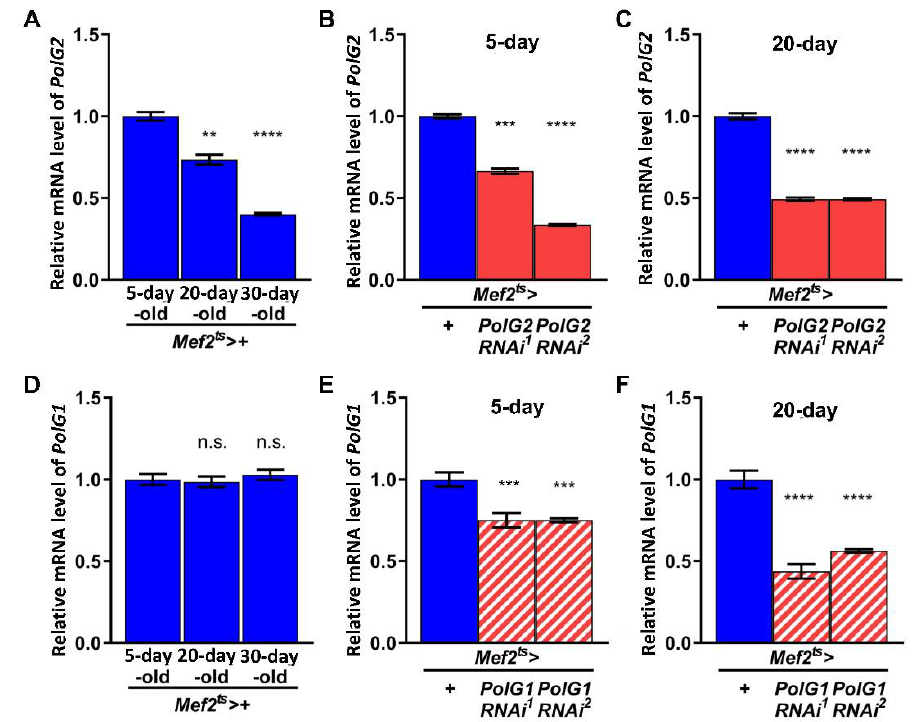
Figure 1. Expression and double-stranded RNA-mediated silencing of mRNAs encoding Pol γ subunits in Drosophila adults with aging. ( A – F ) Relative mRNA levels of PolG2 ( A – C ) and PolG1 ( D – F ) in 5-, 20-, and 36-day-old-flies. ( A , D ) mRNA levels of two genes quantified by qRT-PCR. The average levels in control flies at the same age ( Mef2 ts > + ; the F1 progenies derived from a cross between the Mef2 ts -Gal4 stock and a standard wild stock, Canton S) are presented as 1.0. Note that the mRNA levels of PolG2 mRNA decreased with age, whereas PolG1 mRNA levels remained constant. ( B , C , E , F ) mRNA levels of flies with muscle-specific expression of double-stranded RNA against PolG2 or PolG1 mRNA were quantified by qRT-PCR ( Mef2 ts > PolG2RNAi and Mef2 ts > PolG1RNAi ). The average levels in control flies at the same age ( Mef2 ts > + ) are presented as 1.0. Each mRNA level was reduced to 34–75% of the controls. Error bar; s.e.m. (( A , D ); n = 3 (triplicates), ( B , C , E , F ); n = 9 (three biological triplicates), ** p < 0.01, *** p < 0.001, **** p < 0.0001, n.s. not significant,